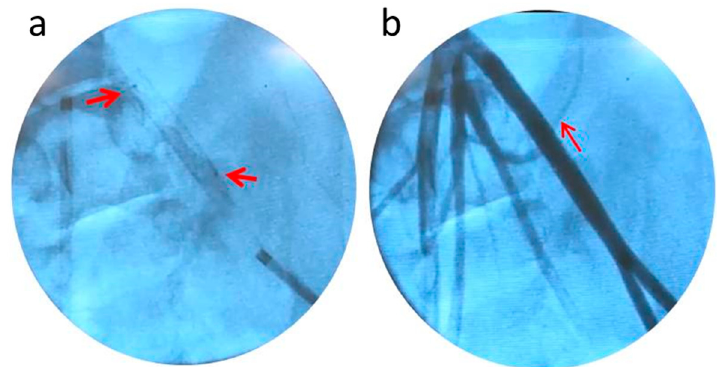
Figure 11. Deployed in situ welded endovascular device: ( a ) The polymer sleeve welded to the stent in the iliac artery of a pig. The arrows point to the radiopaque silver markers; ( b ) Flow of contrast agent through the lumen of the implanted device was undisturbed.